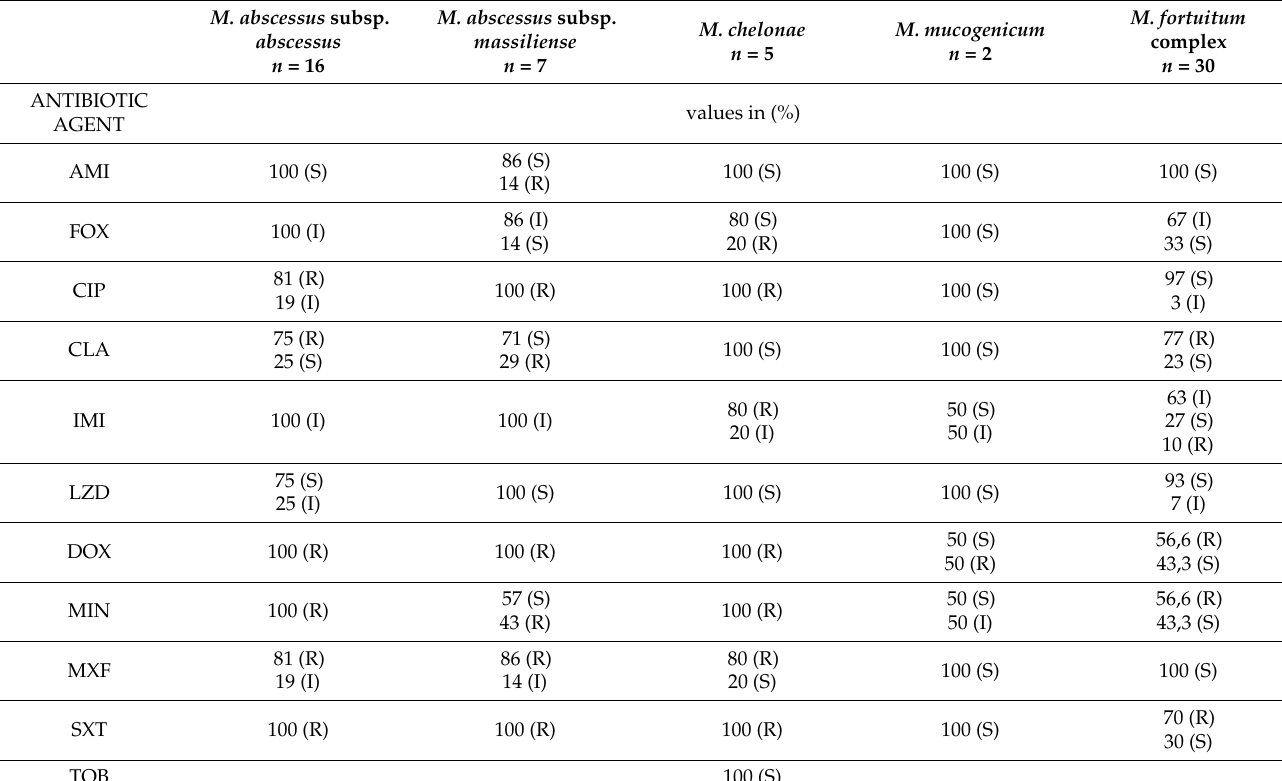
Table 4. Classification of analysed RGM species into groups: (S)-sensitive, (I)-intermediate, and (R)-resistant, based on the measured MIC values.